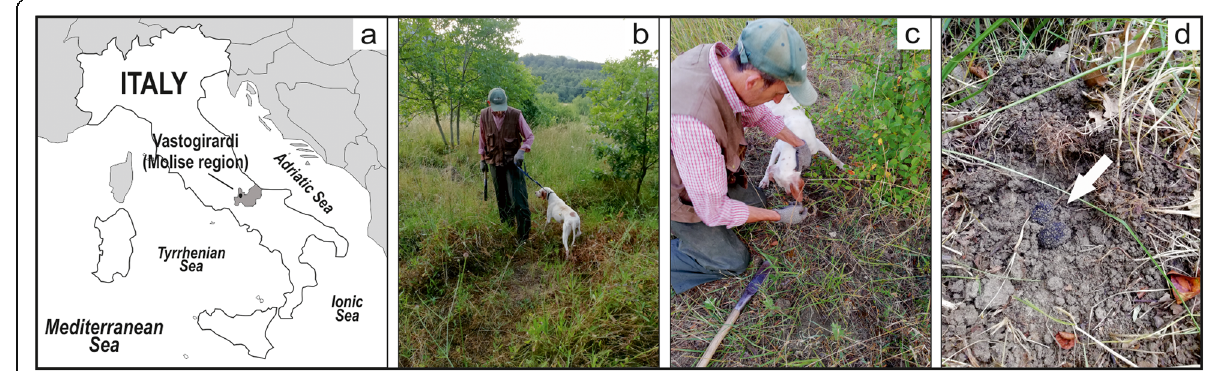
Fig. 1 a Localization of the study area. b , c , d Truffle hunting and ascocarp collection. The white arrow indicates a truffle ascocarp collected during the sampling